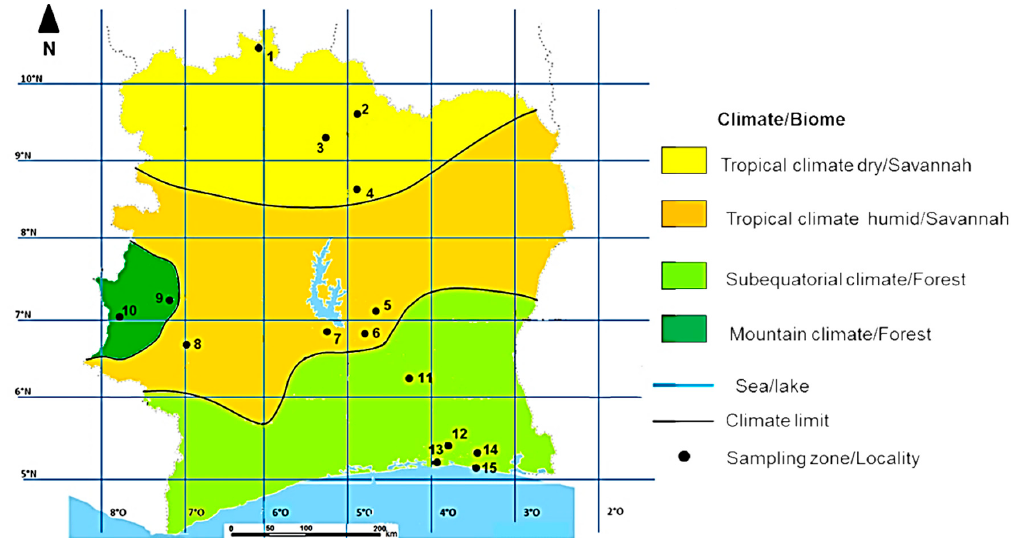
Figure 1. Map of honeybee sampling sites along with different climate and biome types in Côte d’Ivoire. Each sampling locality is presented with a black dot. The 15 sampling localities were spread over the 4 climate types (tropical dry and humid climates, subequatorial dry, and mountain climates) and the 2 biome types (Savannah and Forest). The numbers in the map represent a site with correspondence names and coordinates shown in Table 1.